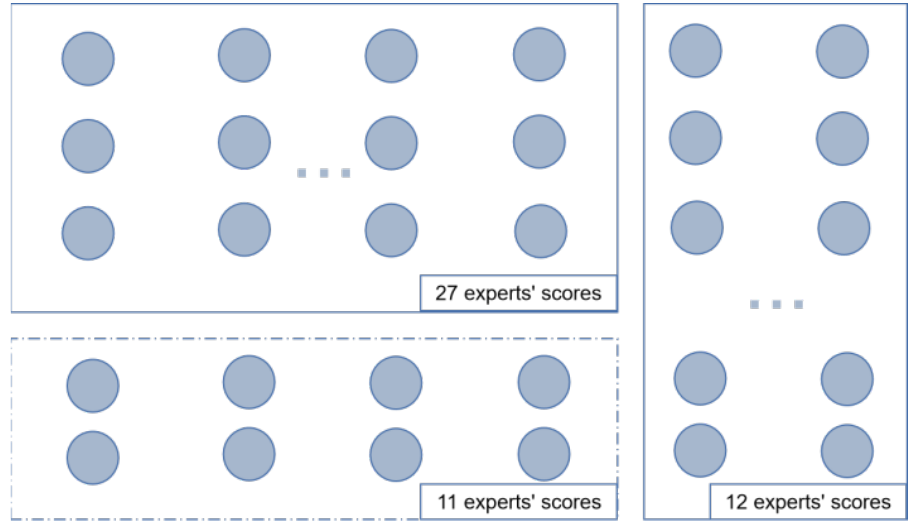
Figure 2. SC algorithm clustering results.